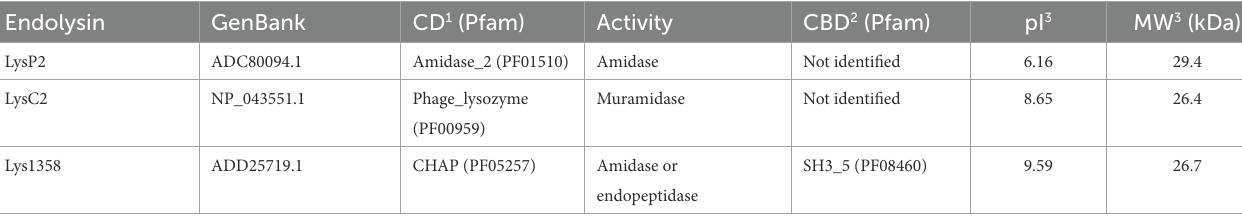
TABLE 2 Biochemical properties of the recombinant lactococcal endolysins used in this work. Endolysin